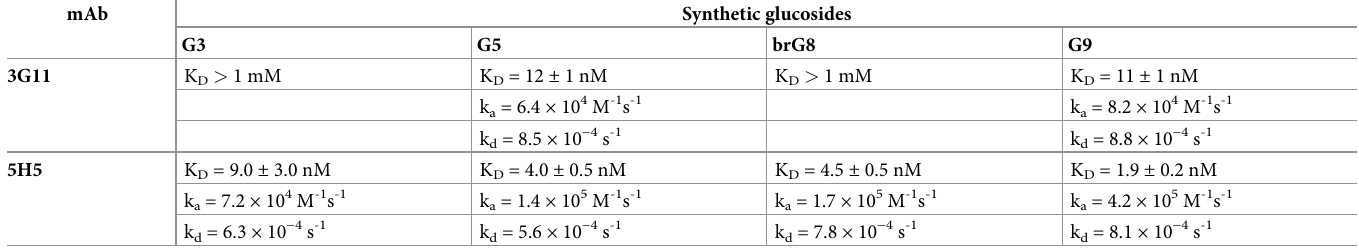
Table 1. The kinetic parameters and affinity constants of mAbs 3G11 and 5H5 for binding with linear tri- (G3), penta- (G5) and nonaglucoside (G9) and branched octaglucoside brG8.